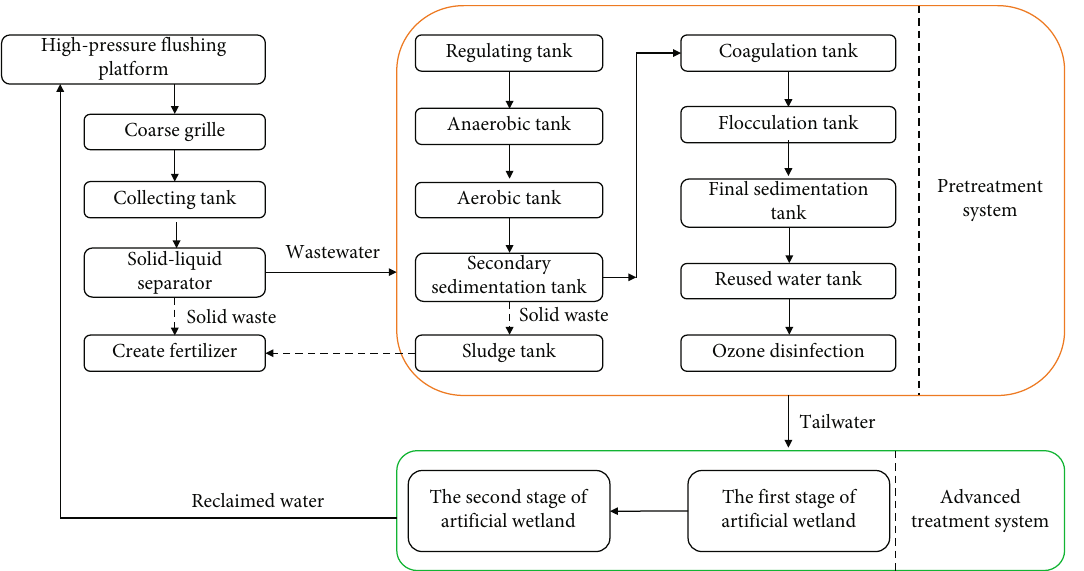
Figure 3: Technical fl ow chart of the phase II